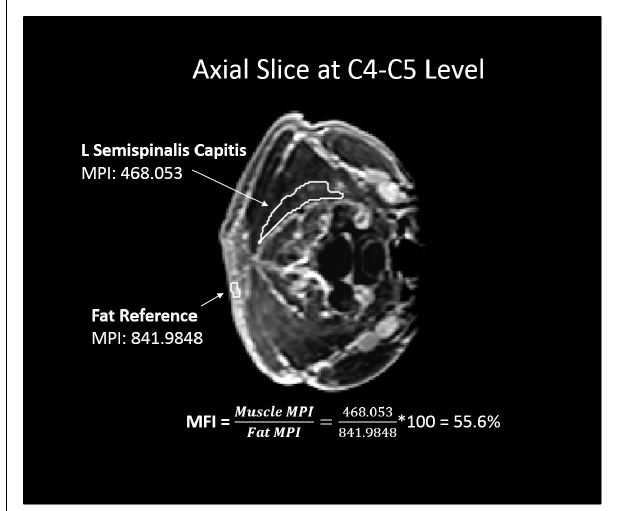
TABLE 1 | Vertebral level of muscle cross-sectional area (CSA) measurements.